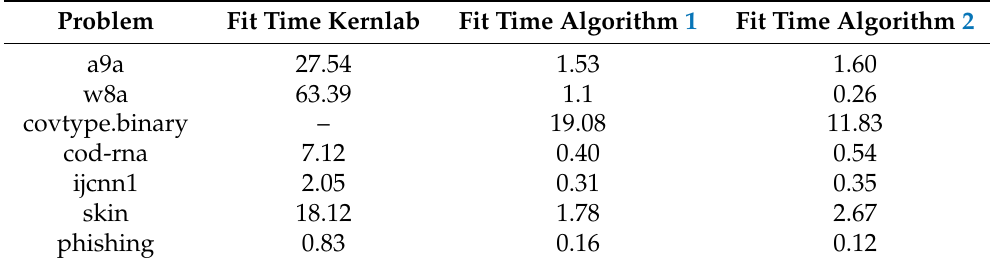
Table 3. CPU estimation times for proposed algorithms and Kernlab over the test sample. For all cases, the test sample is randomly chosen and corresponds to 20% of the complete data set.